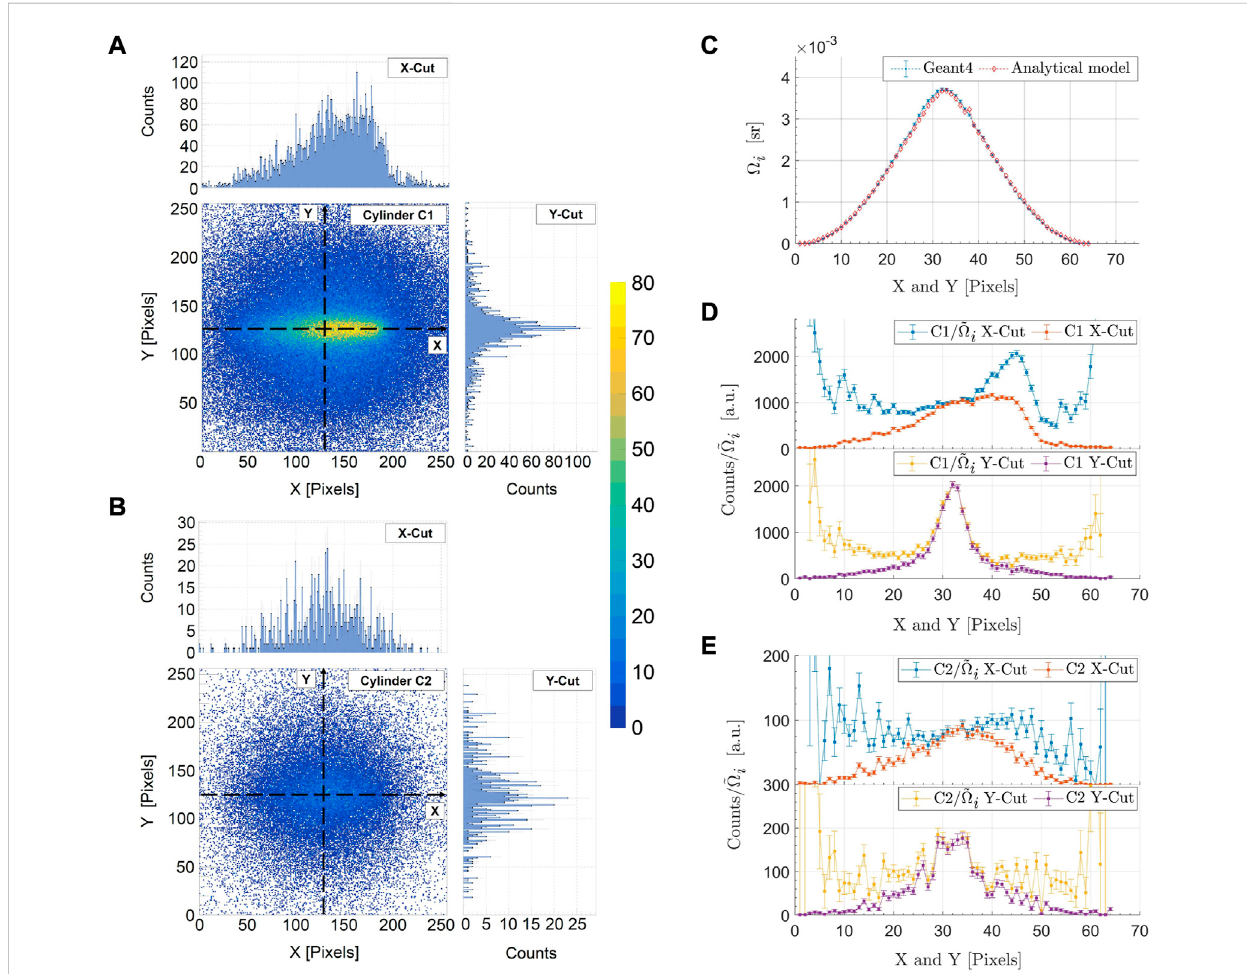
FIGURE 6 Thedetected(MC)spatialdistributionofsingly(C1) (A) anddoubly(C2) (B) scatteredComptonphotonsintheGdK-shellenergyrangeforthesingle- pinhole collimated detector is shown here. The spatial anisotropy of C1 photons (A) about the detector ’ s optical axis can be seen in comparison to the C2 photons (B) . The detection solid angle, Ω i , is compared between MC simulations and an analytical model in (C) . The C1 (D) and C2 (E) photon pro fi les are shown along the horizontal (X-Cut) and vertical (Y-Cut) directions of the detector. The numerical calculations of the analytical model are performed over a 64 × 64-pixel grid in order to minimize computational efforts, resulting in a rebinning of the data in (C , D , E) by combining 4 × 4